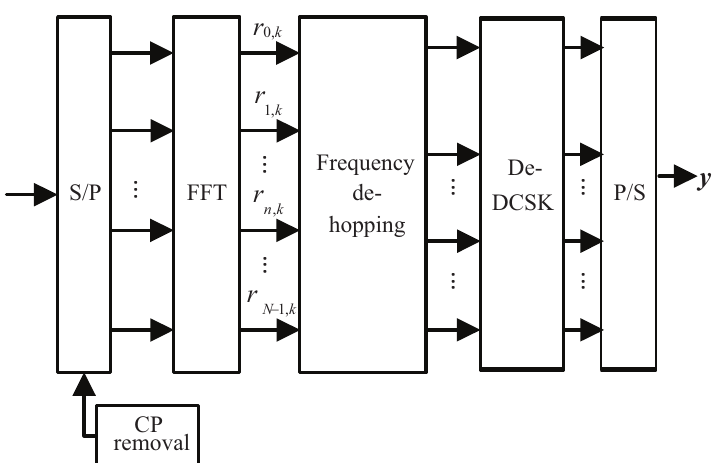
Figure 3. Structure of